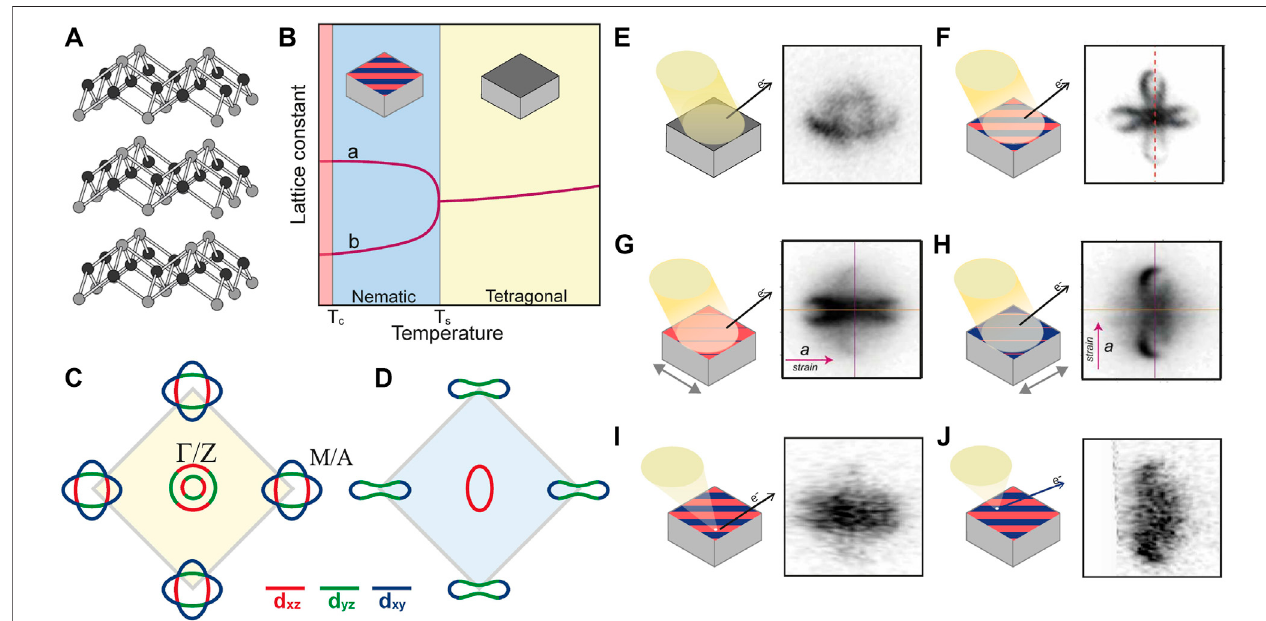
FIGURE 1 | Summary of the Fermi surface of FeSe and photoemission measurements of a single electron pocket. (A) Crystal structure of FeSe, Fe (black), Se (grey). (B) Sketchofthetemperatureevolutionofthelattice constants inFeSe,asdescribedinRef.[44],highlightingtheevolutionfromatetragonal (darkgrey surface)to orthorhombic system with differently orientated domains (red and blue striped surface). (C) Sketch of the experimentally determined Fermi surface of FeSe in the tetragonal state and (D) in the nematic state. (E – J) Summary of the Fermi surface ofFeSe measured around the M/A point via different photoemission techniques. (E) Measurement in the tetragonal state (100 K, LV h ] = 56 eV [32]) showing two electron pockets, (F) ARPES Measurement in the nematic state (10 K, LV, h ] = 56 eV [32]) arising from a superposition of two orthorhombic domain orientations (red and blue regions), referred to as a “ twinned ” measurement. (G,H) ARPES measurement of a detwinned crystal in the nematic state (10 K, h ] = 56 eV [34], where tensile strain is applied either along the a or b crystallographic axis and predominately probes a single domain orientation. (I,J) NanoARPES measurement using a photon beamspot of < 1 μ m (30 K, h ] = 56 eV [41]) in individual orthorhombic